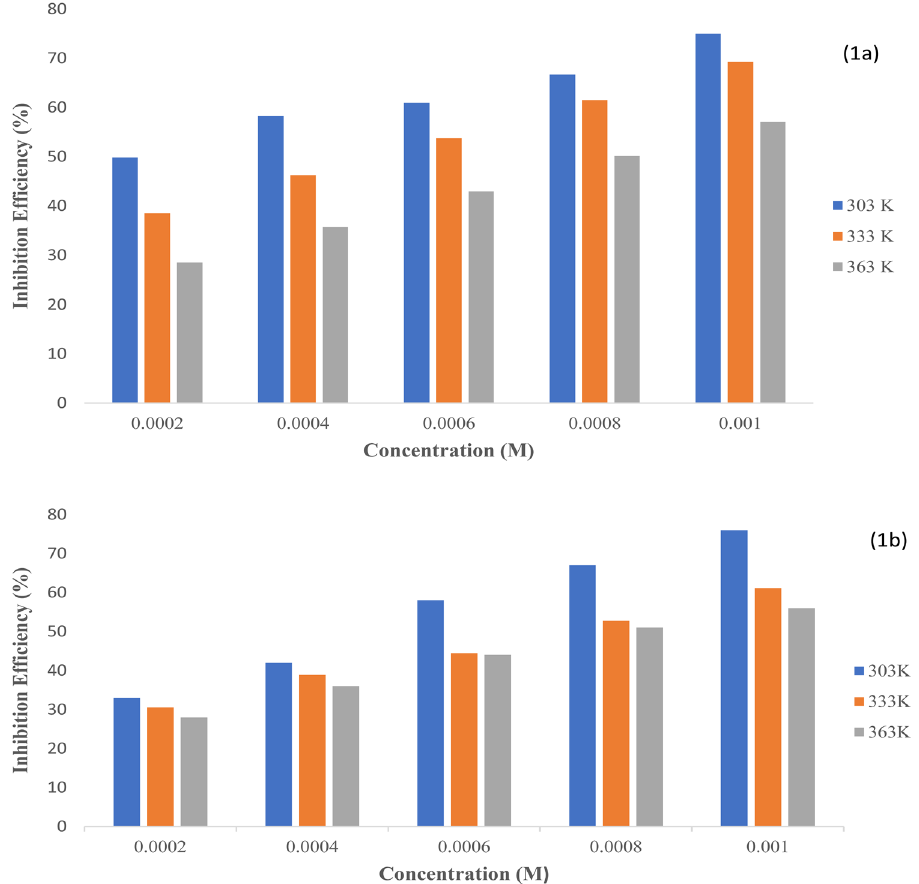
Figure 3. Effect of varying concentration of ( a ) L1 and ( b ) L2 , with varying temperature on inhibition efficiency.